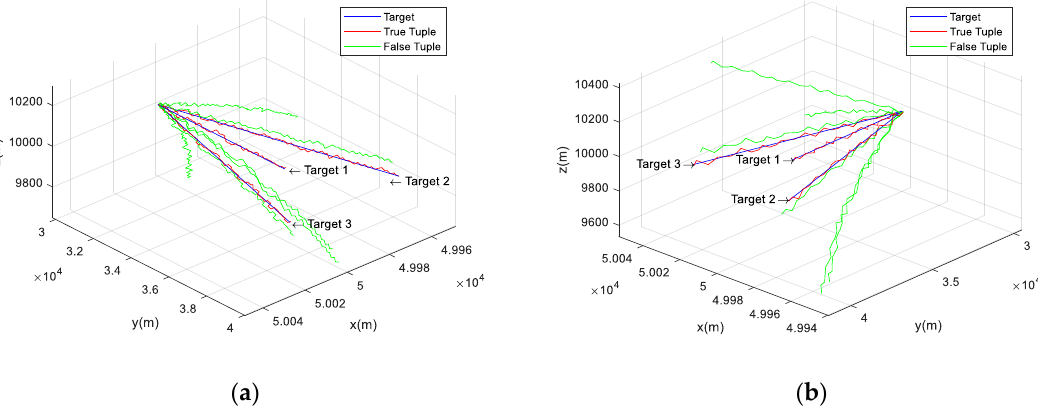
Figure 7. Performance of pairwise fusion model in geometric form. ( a ) All of the potential stereo tracks constructed by sensor 1 and sensor 2. ( b ) All of the potential stereo tracks constructed by sensor 2 and sensor 3. Table 2. Performance of pairwise fusion model with di ff erent